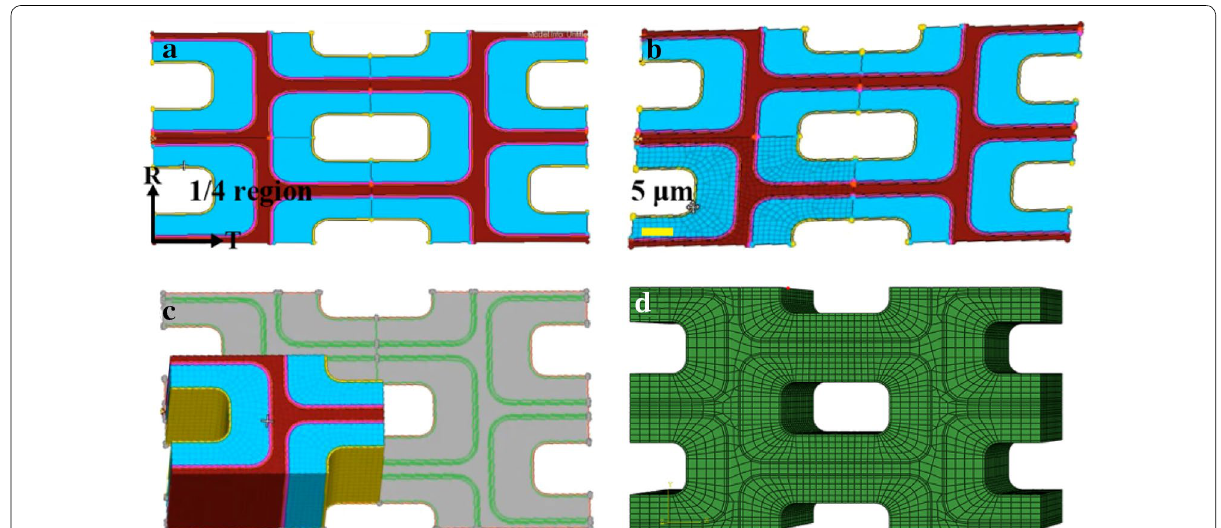
Fig. 4 LW model meshing. a The RT plane of the LW model; b 1/4 RT two-dimensional plane meshing; c 1/4 three-dimensional solid mesh; d the LW model